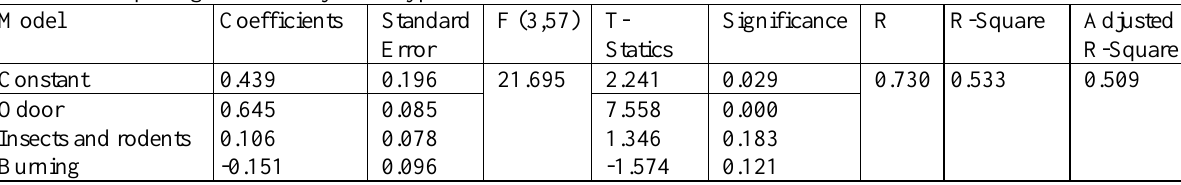
Table 6. Multiple regression analysis of hypothesis twos Model